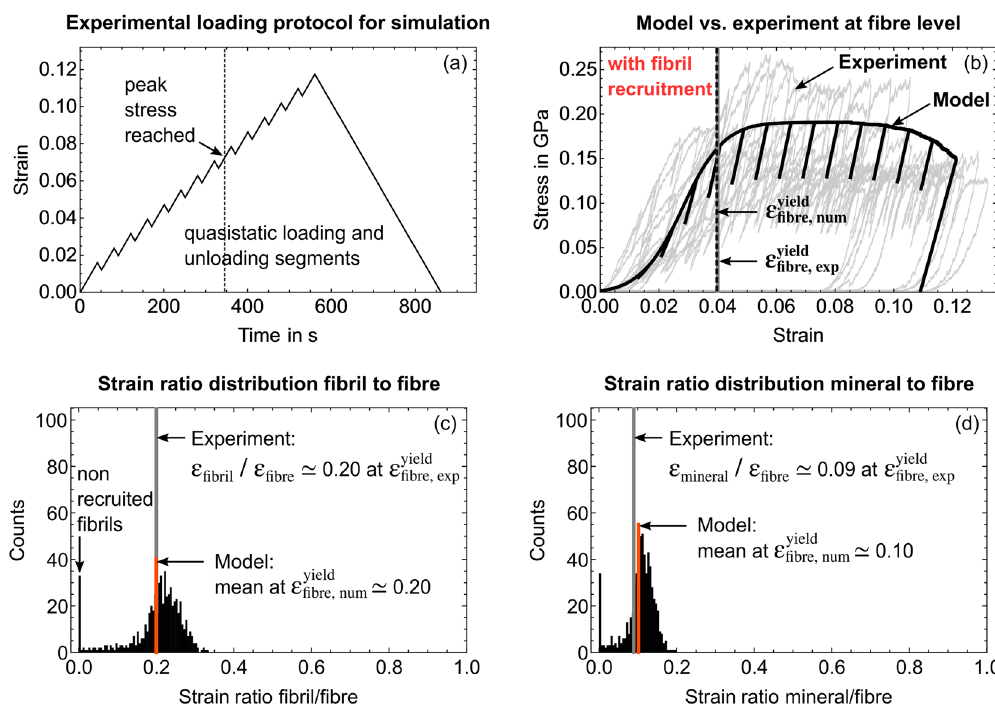
Figure 6. Model outcome for a simulated mineralised collagen fibre where we consider non-linear fibril recruitment. Grey curves and lines represent experimental values 39 . ( a ) Experimental loading protocol. ( b ) Overlay of simulated stress-strain curve (black) and 11 experimental curves (grey) from fibre compression 39 . ( c,d ) Simulated strain ratio distributions for ( c ) fibril-to-fibre and ( d ) mineral-to-fibre at simulated yield strain of 3.9% (black dotted line) with still 35 non recruited fibrils ( c ). A comparison between model and experiment is given in Table 1. The full loading cycle is provided in Supplementary Video